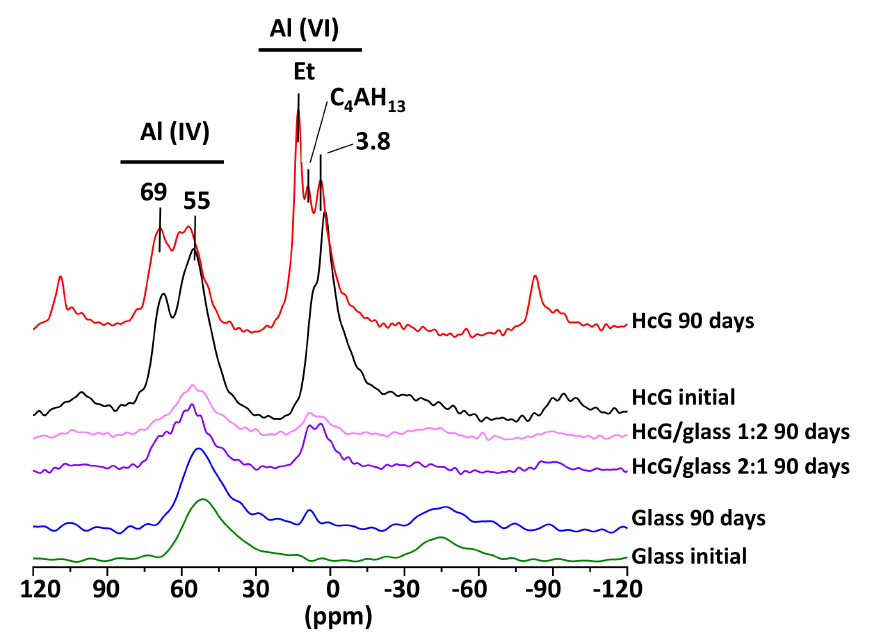
Figure 3. NMR of the 29 Al cores of the initial HcG and glass mixtures and binary mixtures at 90 days (Et =